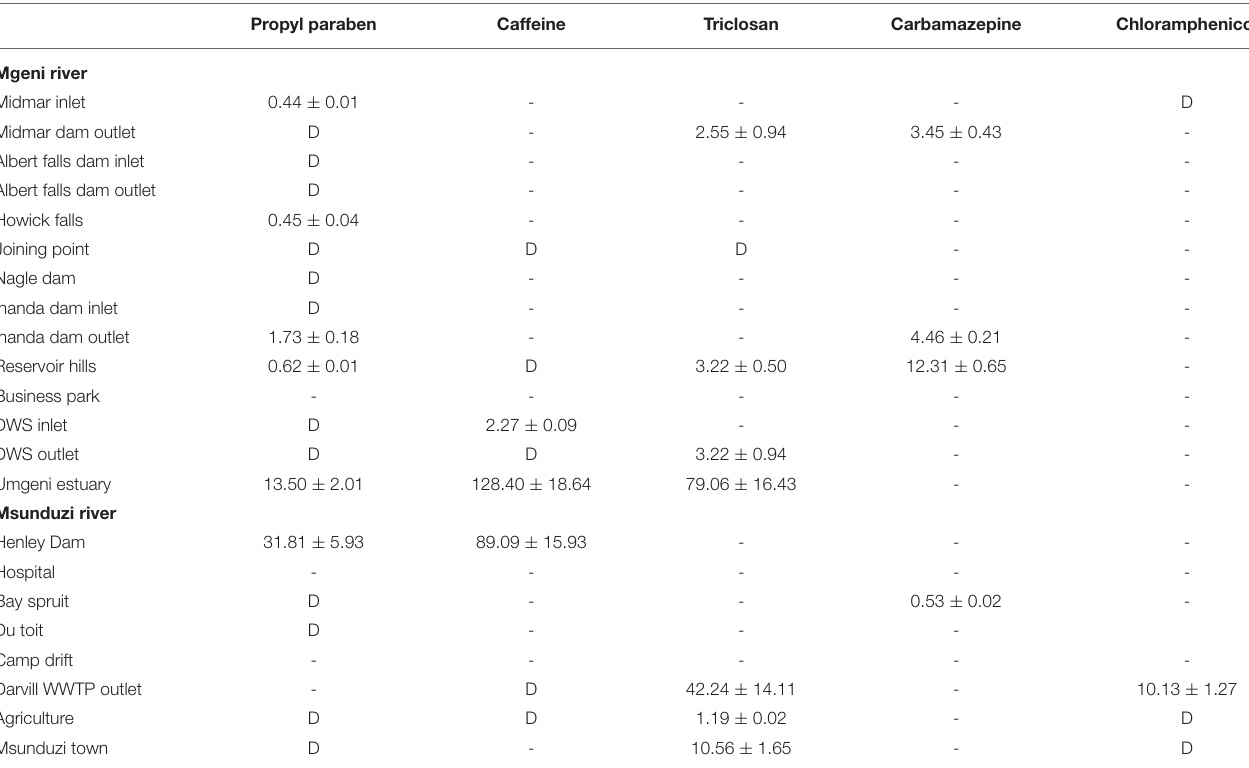
TABLE 3 | Concentration of the studied compounds (ng g − 1 ) in sediments collected in Mgeni and Msunduzi rivers in